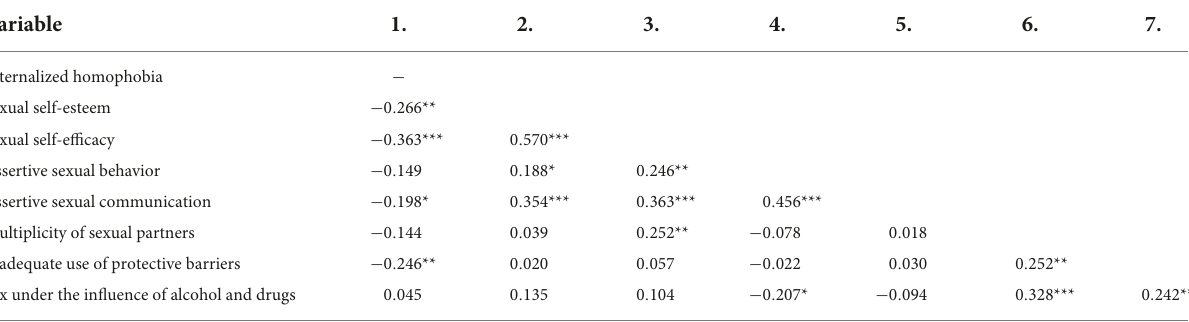
TABLE 2 Correlation coefficients between